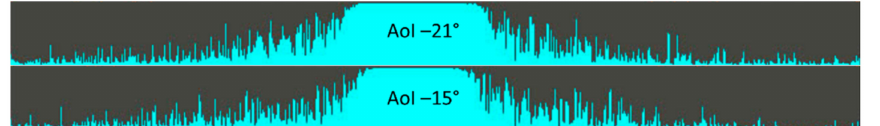
Figure 14. Raw intensity data for red plexiglass at AoI − 21 ◦ and − 15 ◦ . Points in the laser line are no longer detected on the left and right side because of the low laser intensity; we can also observe the noise which leads to a high occurrence of outliers.